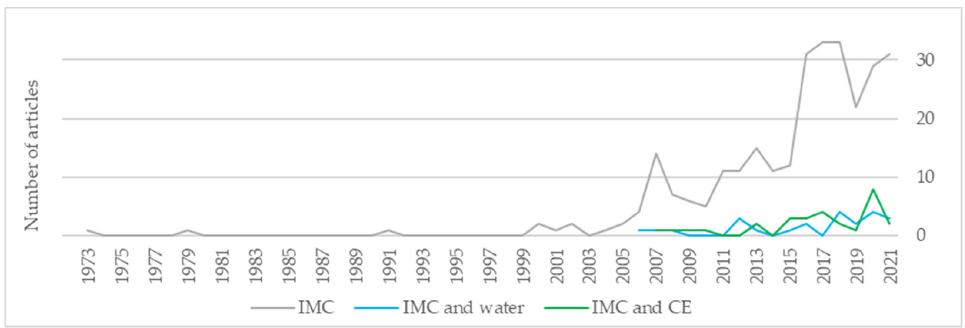
Figure 1. Number of articles on IMC, IMC and water, as well as IMC and CE.